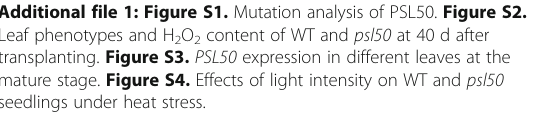
transplanting. Figure S3. PSL50 expression in different leaves at the mature stage. Figure S4. Effects of light intensity on WT and psl50 seedlings under heat